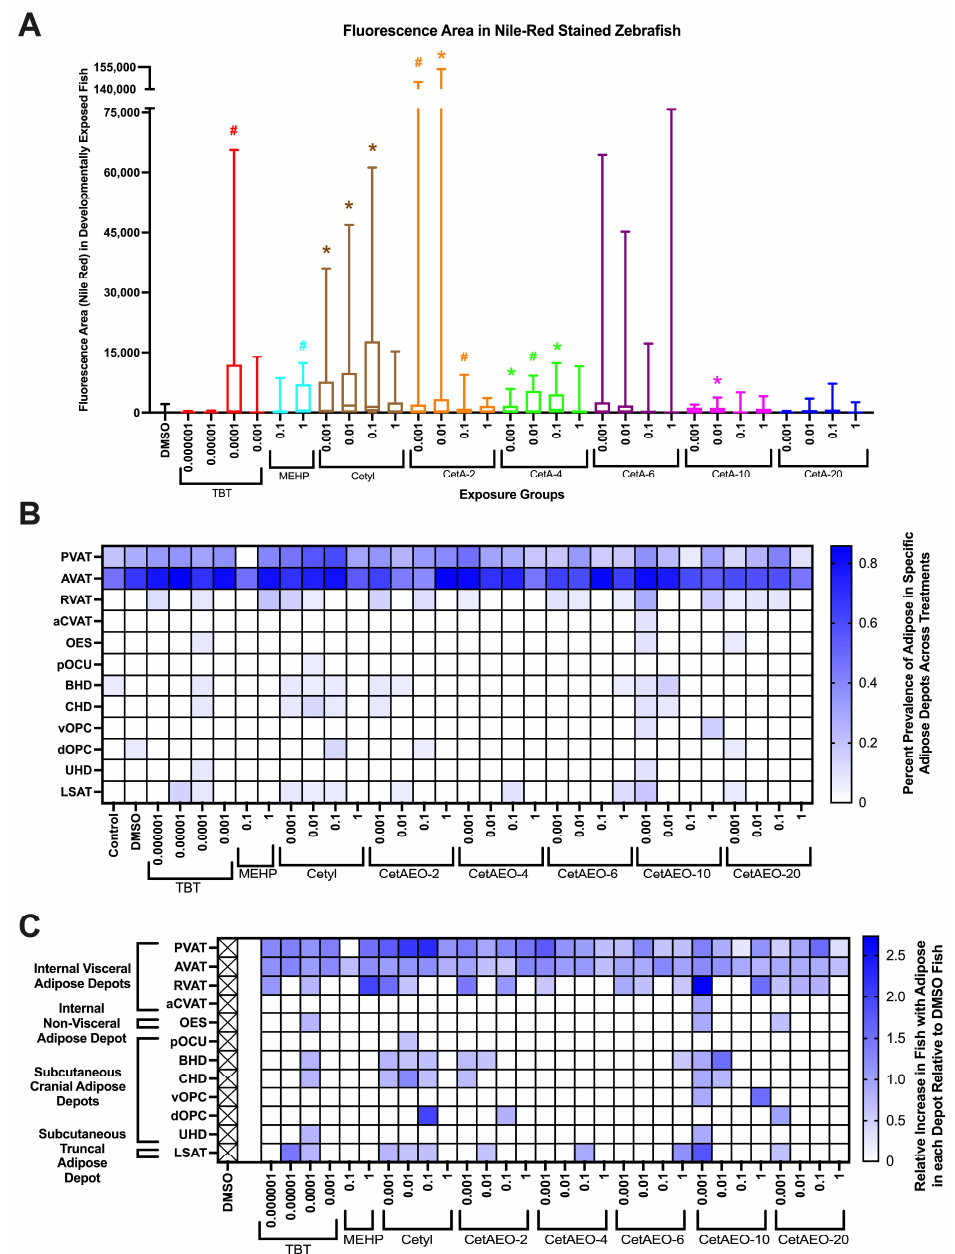
Figure 6. Adipose Deposition in Zebrafish Developmentally Exposed to Cetyl Alcohol and Polyethoxylates. Zebrafish were developmentally exposed to control chemicals, cetyl alcohol, or cetyl alcohol polyethoxylates (CetAEO − 2 − 20), aged to 30 days post fertilization, and then measured and stained with Nile Red, as described in Methods. The area of total body fluorescence ( µ m 2 ; ( A )) was imaged at 16 × magnification using a yellow fluorescent protein filter, and fluorescence was quantified for each fish, and then biological replicates were averaged. N = 16 DMSO, 14, 14, 15, 11, 17, 6, 13, 16, 15, 20, 14, 16, 17, 13, 17, 13, 11, 15, 11, 15, 11, 17, 11, 13, 15, 13, 15, 12, 12, and 11 across four spawning events (biological replicates) for exposure groups listed above, respectively. * indicates significant increase in total body fluorescence quantification over vehicle control fish, p < 0.05, as per Kruskal–Wallis test and # represents 0.05 < p < 0.10. Box and whisker plots depict the following metrics: whiskers represent 10–90th percentiles, box bounds represent the 25th to 75th percentiles, and the middle line represents the median. Developmental trajectory of adipose depots across the zebrafish ( B , C ). Percent of fish in each group with demonstrable fluorescing adipose within each exposure group ( B ) and relative proportions of fish exhibiting fluorescing adipocytes in each depot ( C ). Relative values in the DMSO fish were set as “normal”, and the heat map depicts increased or